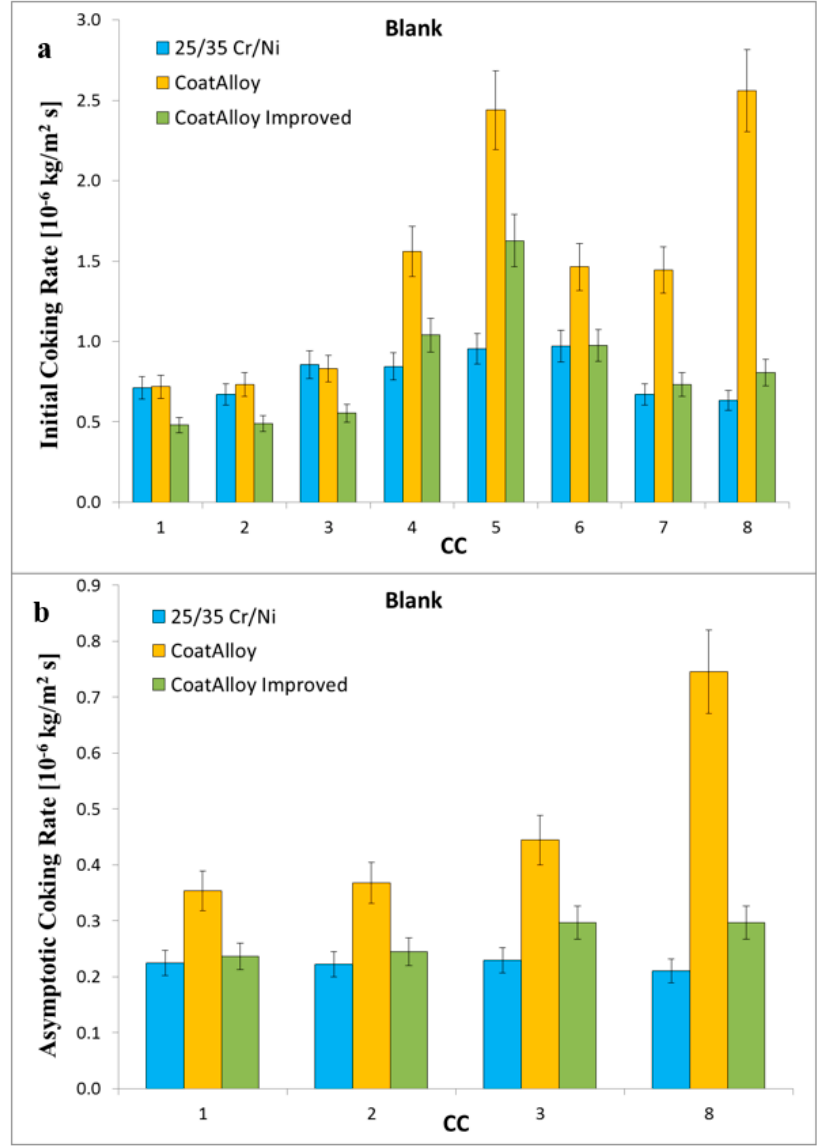
Figure 3. Initial ( a ) and asymptotic ( b ) coking rates for the Blank runs for the reference (blue), CoatAlloy™ (yellow), and CoatAlloy™ with the Steam/Air pretreatment (green).